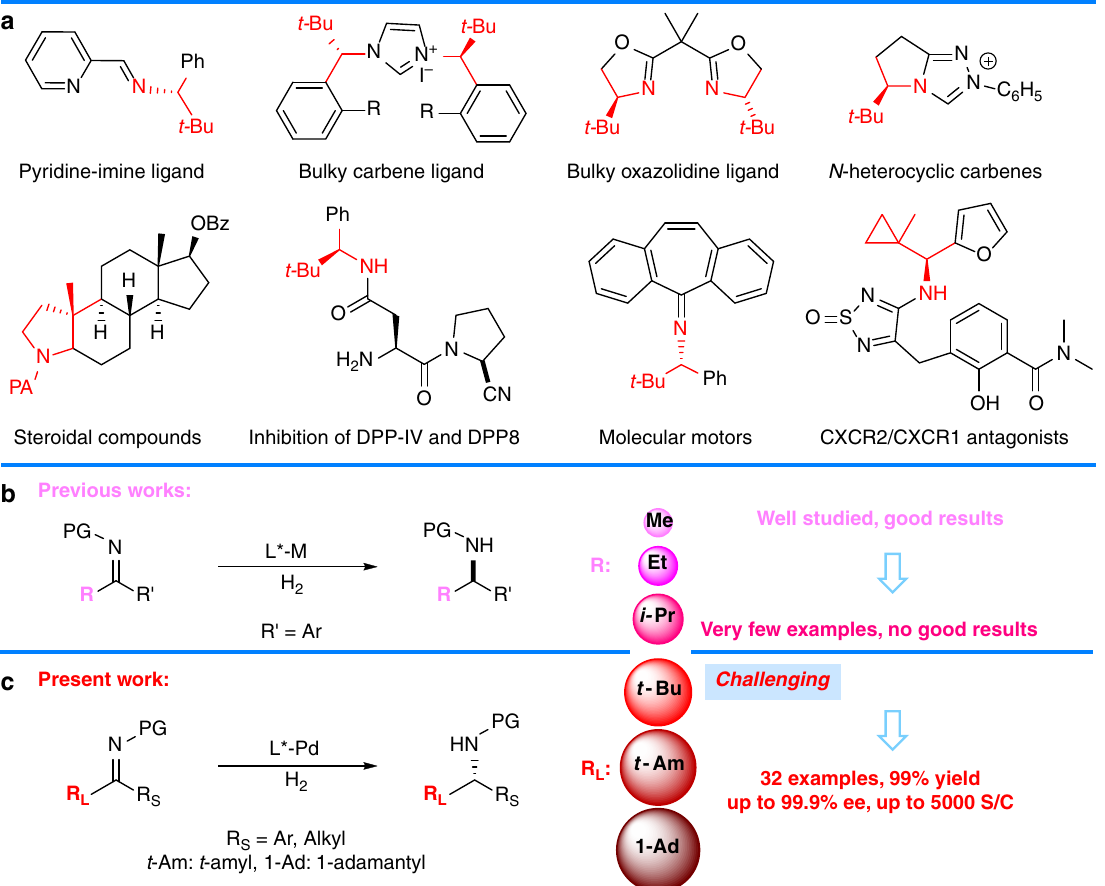
Fig. 1 Asymmetric hydrogenation of imines for preparation of chiral amines. a Representative chiral ligands and bioactive compounds bearing sterically hindered chiral amine skeletons. b Previous work about asymmetric hydrogenation of imines. c This work: Pd-catalyzed asymmetric hydrogenation of sterically hindered